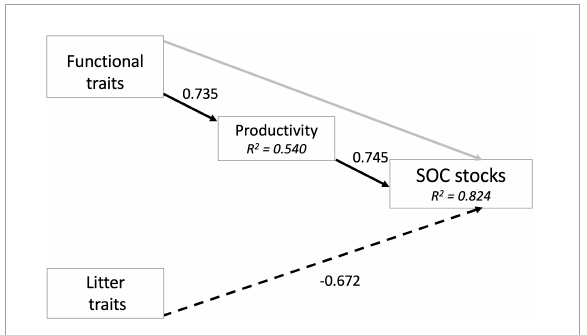
FIGURE4 Path models demonstrating relationships among plant and litter traits, tree productivity, and species-specific soil organic C (SOC) stocks. Significant paths are shown in black, and non-significant paths in gray; dotted lines indicate negative relationships. Numbers beside each line are correlation